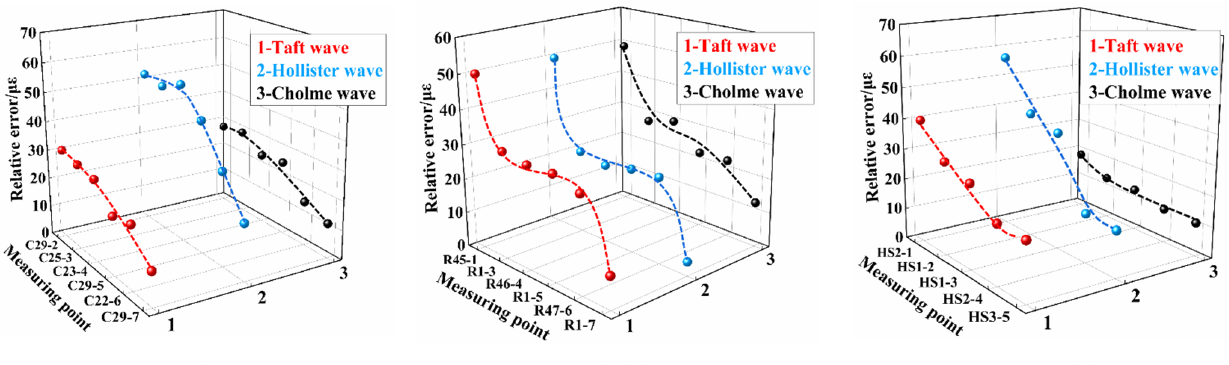
Figure 18. Relative errors of peak strain between the two models.